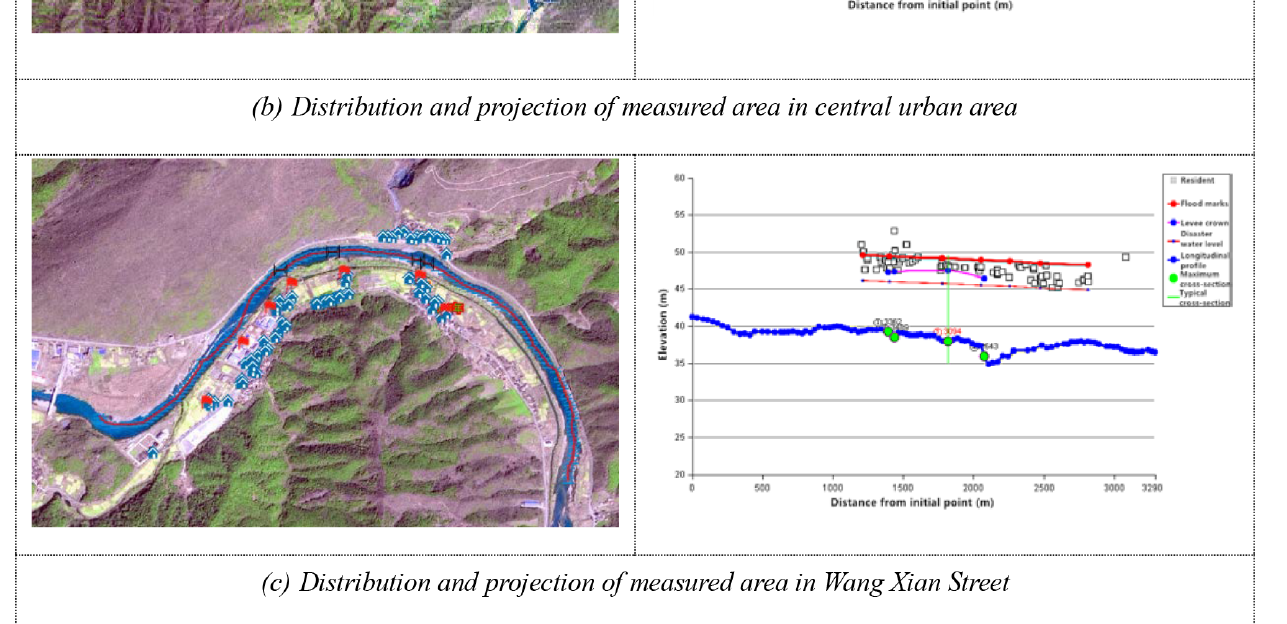
Figure 7. Diagram of water level and height projection of building foundation in each measuring area (map data © MapWorld Anhui, http://anhui.tianditu.gov.cn, last access: August